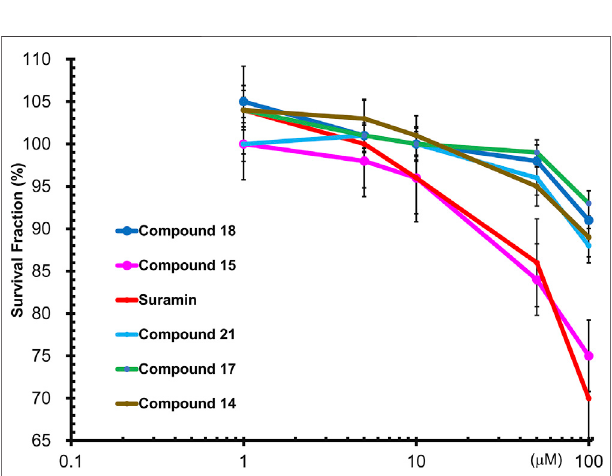
FIGURE 6 | Wst1-Assay results of cytotoxicity of FGF1 with fi ve compounds ( 14, 15, 17, 18 and 21 ): Compound 14 in brown, Compound 15 inpink,Compound 17 ingreen,Compound 18 inblue,Compound 21 incyan, and suramin in red.